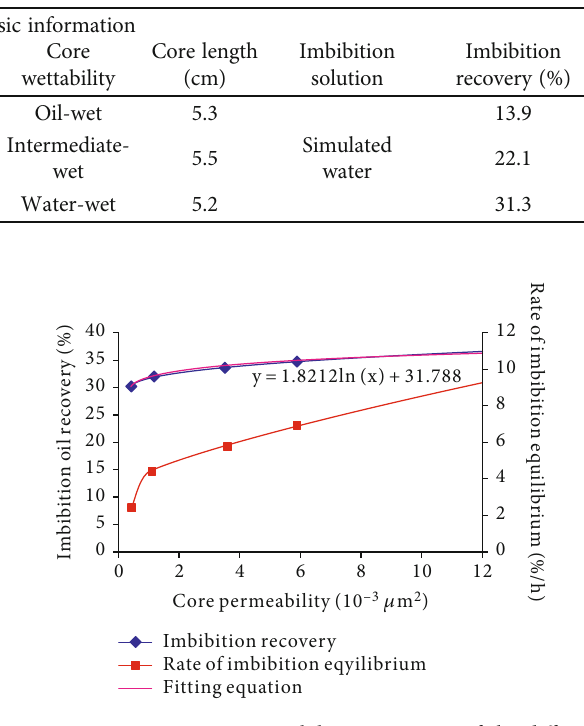
2: Static spontaneous imbibition recovery of the di ff erent permeability cores of